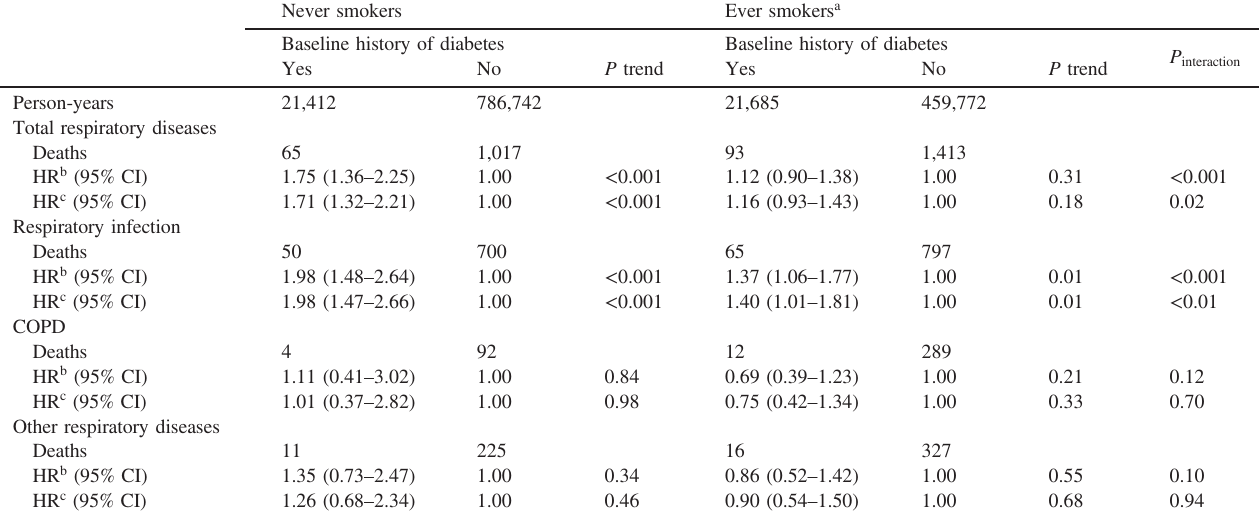
Table 4. Age-adjusted and multivariable hazard ratios (HRs) of mortality from respiratory diseases according to baseline history of diabetes, strati fi ed by smoking